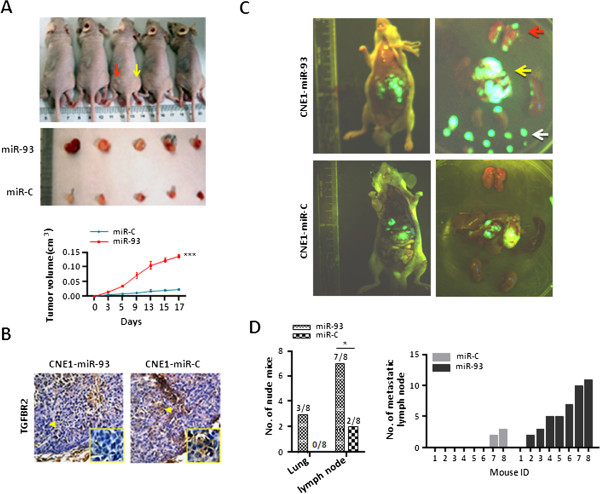
MiR-93-mediated TGFβR2 down-regulation facilitates NPC aggressiveness in vivo. (A) Tumor cells were subcutaneously injected into nude mice (5 mice each group). Pictures of subcutaneous tumor tissues were showed in whole nude mice injected with CNE1-miR-93 cells (red arrow) and CNE1-miR-C cells (yellow arrow). Tumor volumes were determined by measuring the major (a) and minor (b) diameters at the indicated time points, calculated according to the formula = 0.5 × a × b2, and plotted as the mean ± SD. ***P < 0.001. (B) TGFβR2 protein expression was examined using IHC in tumor tissues derived from the indicated mouse group (400×). (C) The representative GFP images of mouse models transplanted by CNE1-miR-93 cells (upper) and CNE1-miR-C cells (lower). The whole mouse body and resected organs were showed separately. The primary and metastatic tumors were displayed with green fluorescence under whole body imaging system. In the GFP images of resected organs, the lungs (red arrow), liver (yellow arrow), kidneys, and lymph nodes (white arrow) were placed from the upper to bottom respectively and the spleen is at the right side. (D) The differences of pulmonary or lymphatic metastasis between two groups (n = 8 per group; Fisher’s exact test. *P < 0.05) and the number of lymph node metastasis of mice (mean ± SD, 5.375 ± 1.349 and 0.625 ± 0.4799 in miR-93 cells and control cells respectively, P = 0.0046).